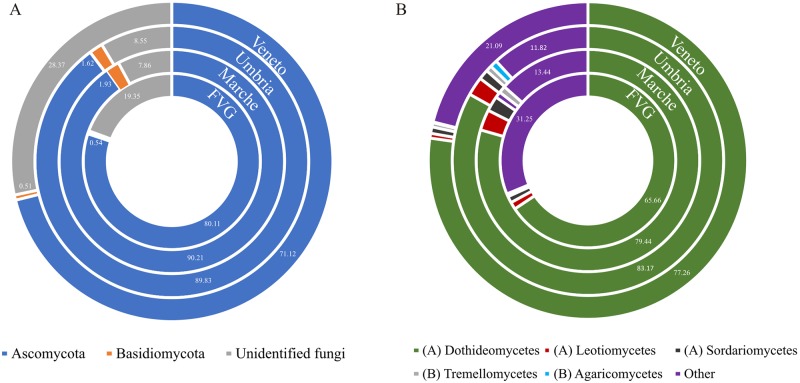
Doughnut charts showing fungal taxonomic composition at division (A) and class (B) level in the four sampling sites.Relative abundances of taxa are reported in percentage. “Unidentified fungi” comprehends Fungi sp. and fungi with no blast hit. Taxa accounting for <0.1% of reads are grouped as “other”.